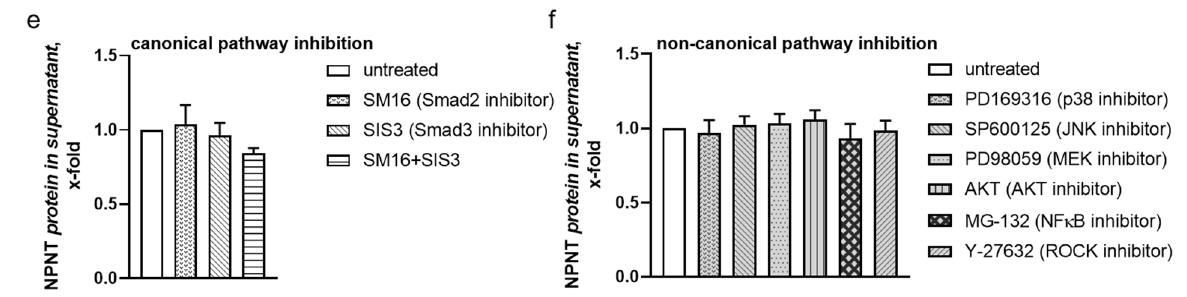
Figure 4. Non-canonical pathways predominantly mediate post-transcriptional regulation of NPNT under baseline conditions. ( a , b ) qPCR for NPNT mRNA in cultured human podocytes, untreated and after treatment with inhibitors of the non-canonical pathways ( a ), PD169316, SP600125, PD98059, AKT inhibitor, MG-132, and Y-27632, or with SM16 and/or SIS3 for canonical pathway inhibition ( b ). NPNT mRNA expression normalized to HPRT is given as the change compared to untreated cells. n = 6–7 independent experiments; ** p < 0.01. ( c , d ) NPNT protein expression in cultured human podocytes, untreated and after treatment with different inhibitors of the non-canonical ( c ) and the canonical pathways ( d ) as described in ( a , b ). NPNT protein expression, normalized to GAPDH, is given as the change compared to untreated cells. A representative Western blot result is shown for each treatment. n = 6–11 independent experiments; n.s. = not significant, * p < 0.05. ( e , f ) Human podocytes were treated as described in ( a , b ). NPNT protein expression was measured by ELISA in the cell culture supernatant and plotted as the change compared to untreated controls. n = 3 independent